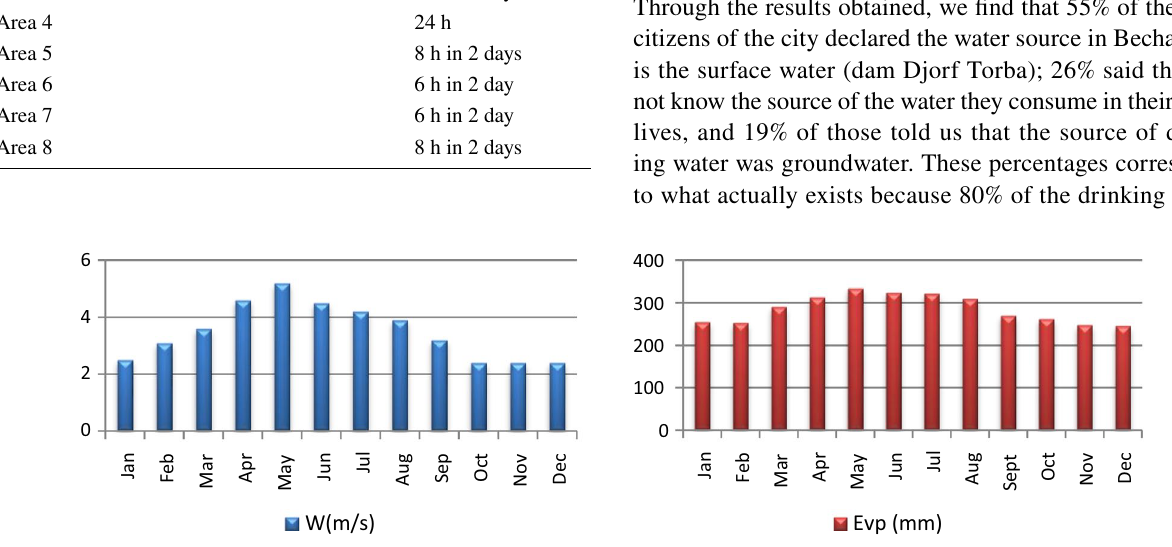
Fig. 3 Wind speeds and average monthly evaporations in Bechar city during the period 1985–2015 (Kendouci